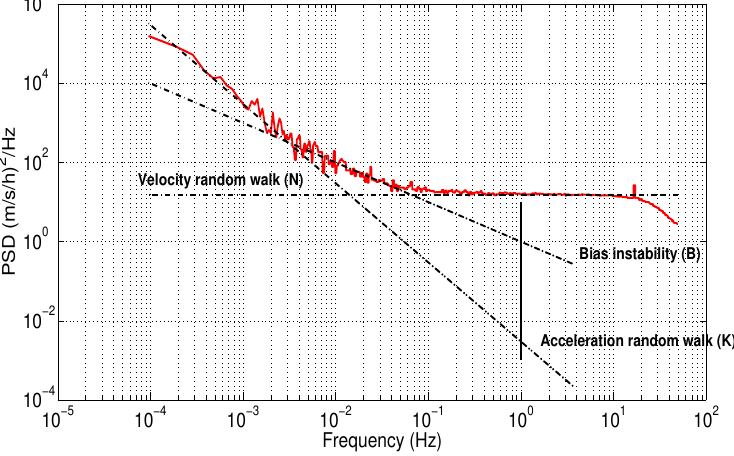
Figure 13. Power spectral density accelerometer Z IMU 3DM-GX-25.